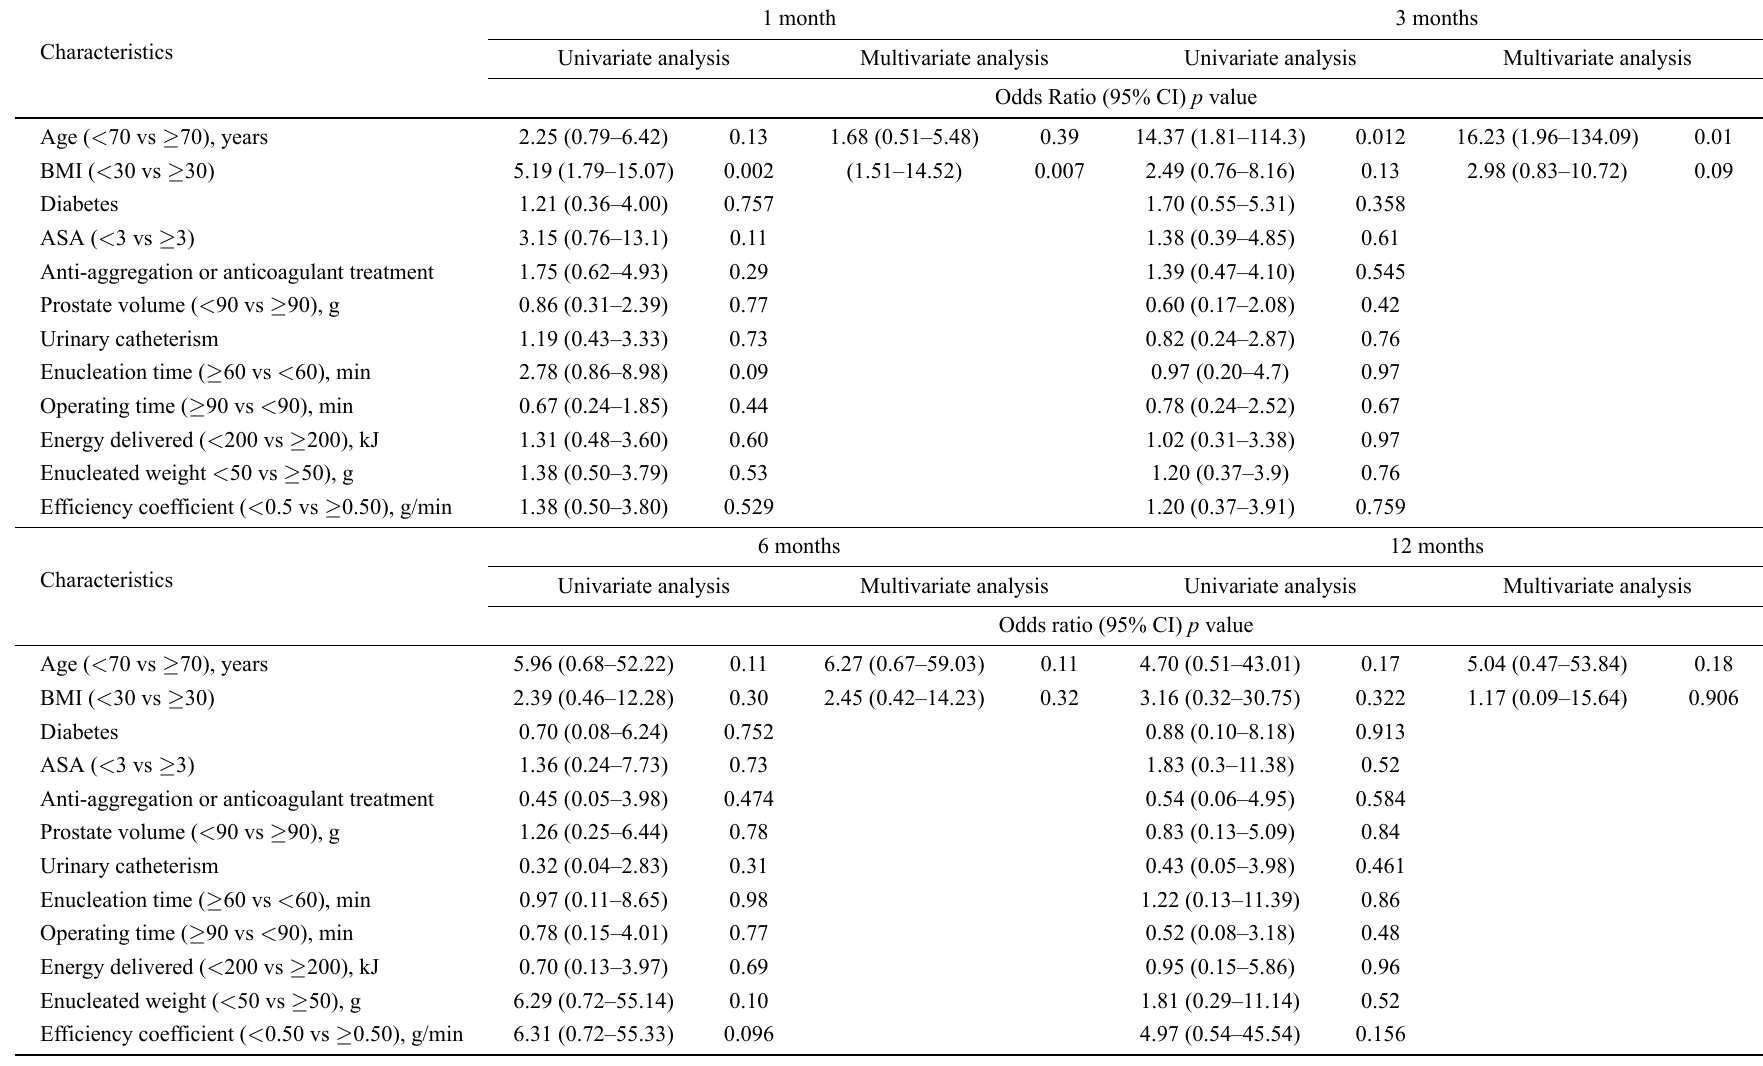
Table 3. Univariate and multivariate logistic regression analysis for predicting postoperative stress urinary